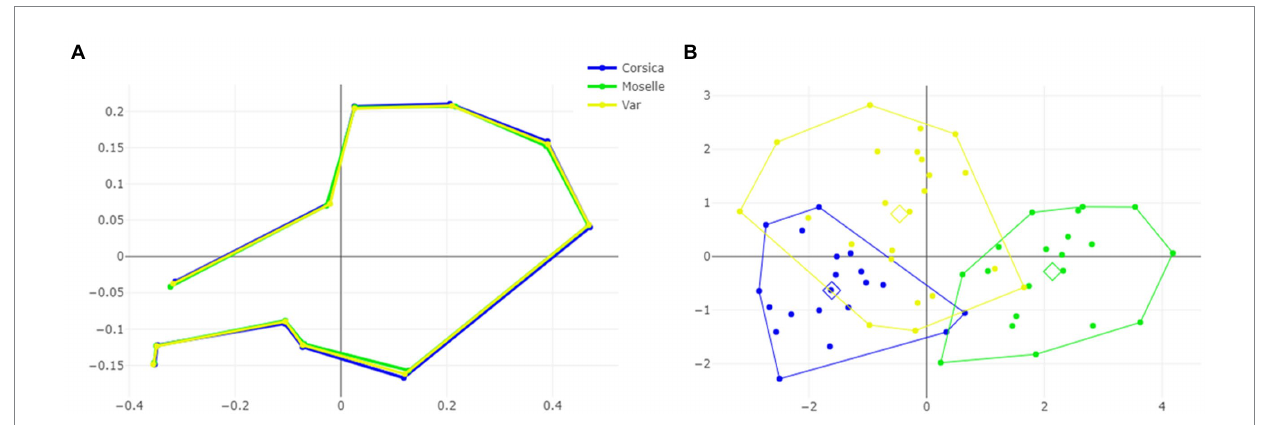
FIGURE 5 Shape variation of Culicoides circumscriptus based on landmarks. Superposition of the geometric morphometric set landmarks (A) in three geographically distant sites. Factor map of the two discriminant factors (DFs) among three sites (B) . Each point represents an individual. The horizontal axis is the first DF; the vertical axis is the second DF; their cumulated contributions reach 100% of the total variation.